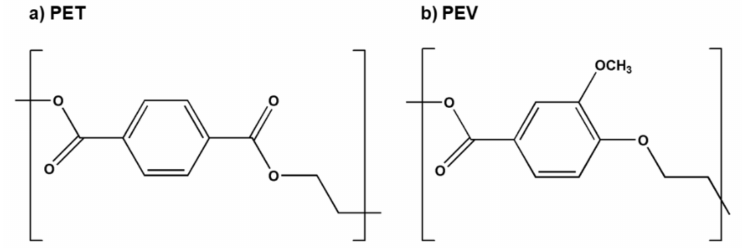
Figure 1. Chemical structure of ( a ) polyethylene terephthalate (PET) and ( b ) polyethylene vanil- late